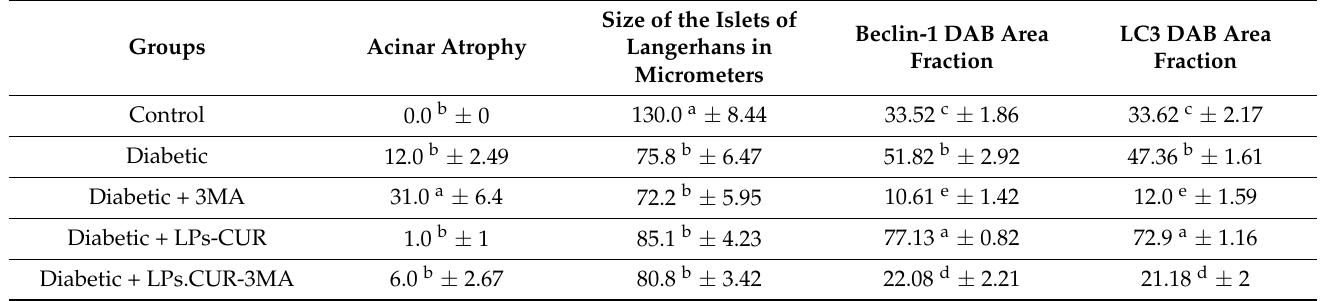
Table 2. Effect of diabetes (STZ) (65 mg/kg b.wt), 3MA (10 mg/kg b.wt), LPs-CUR (10 mg/kg b.wt.) oral dosing for 10 weeks on the [pancreatic tissue lesion scoring of all treated groups and control.